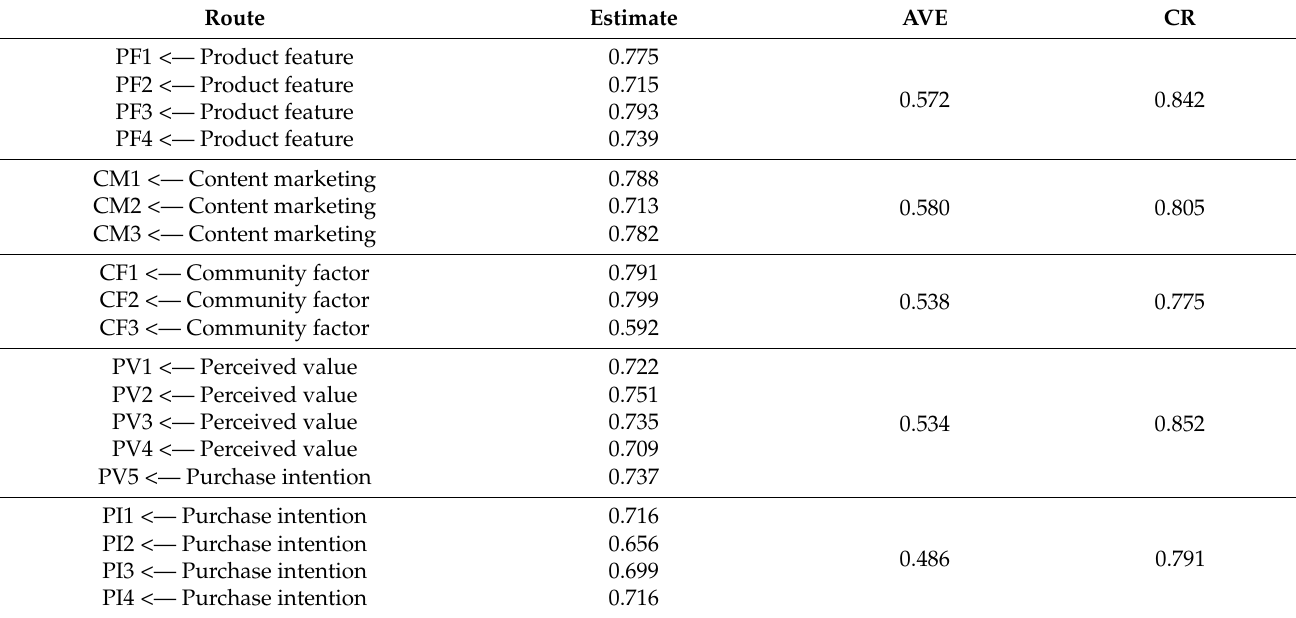
Table 6. Results of convergent-validity test.